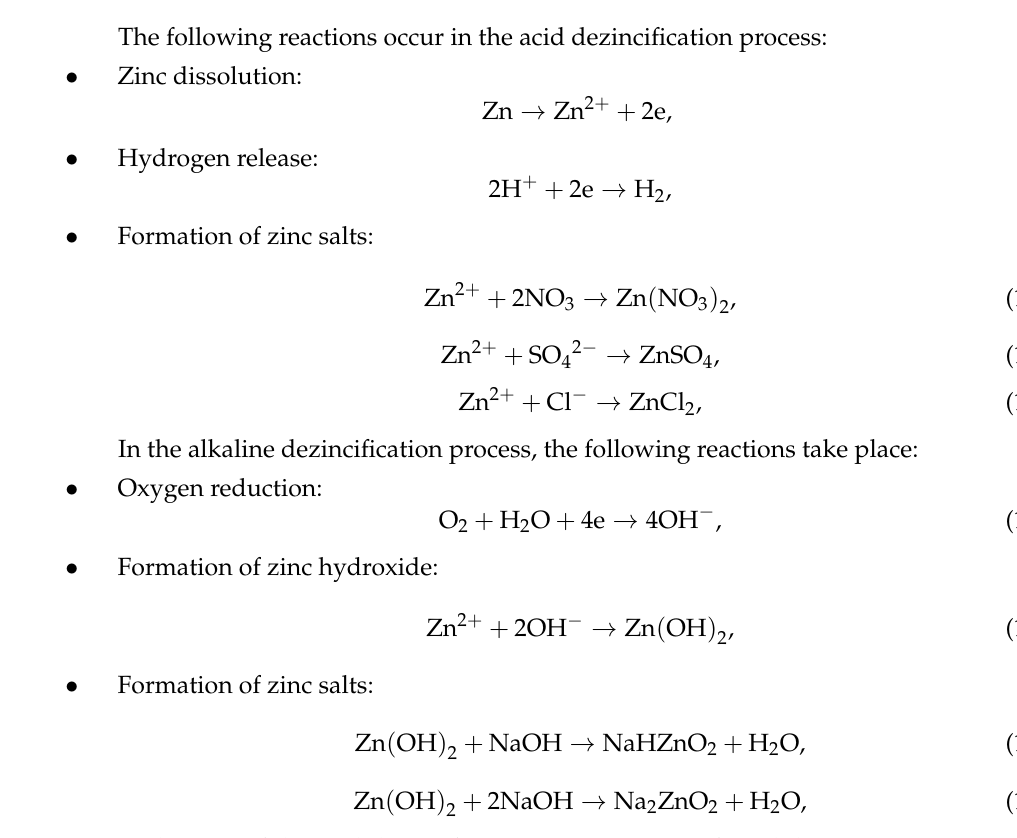
Figure 8. Scheme: ( a ) acidic and ( b ) alkaline dezincification of galvanized products